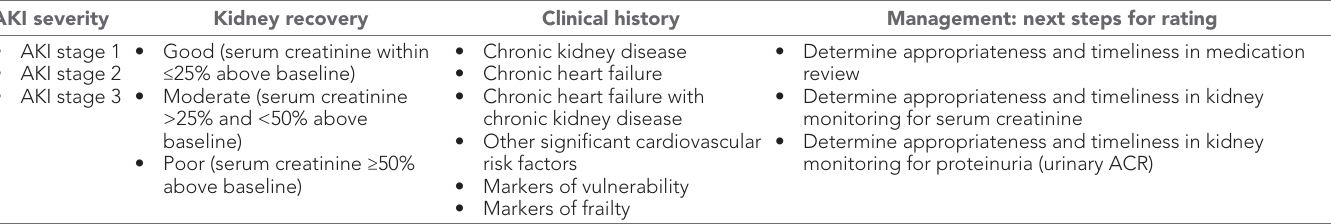
Table 1 Key characteristics of categorisations of the clinical scenarios